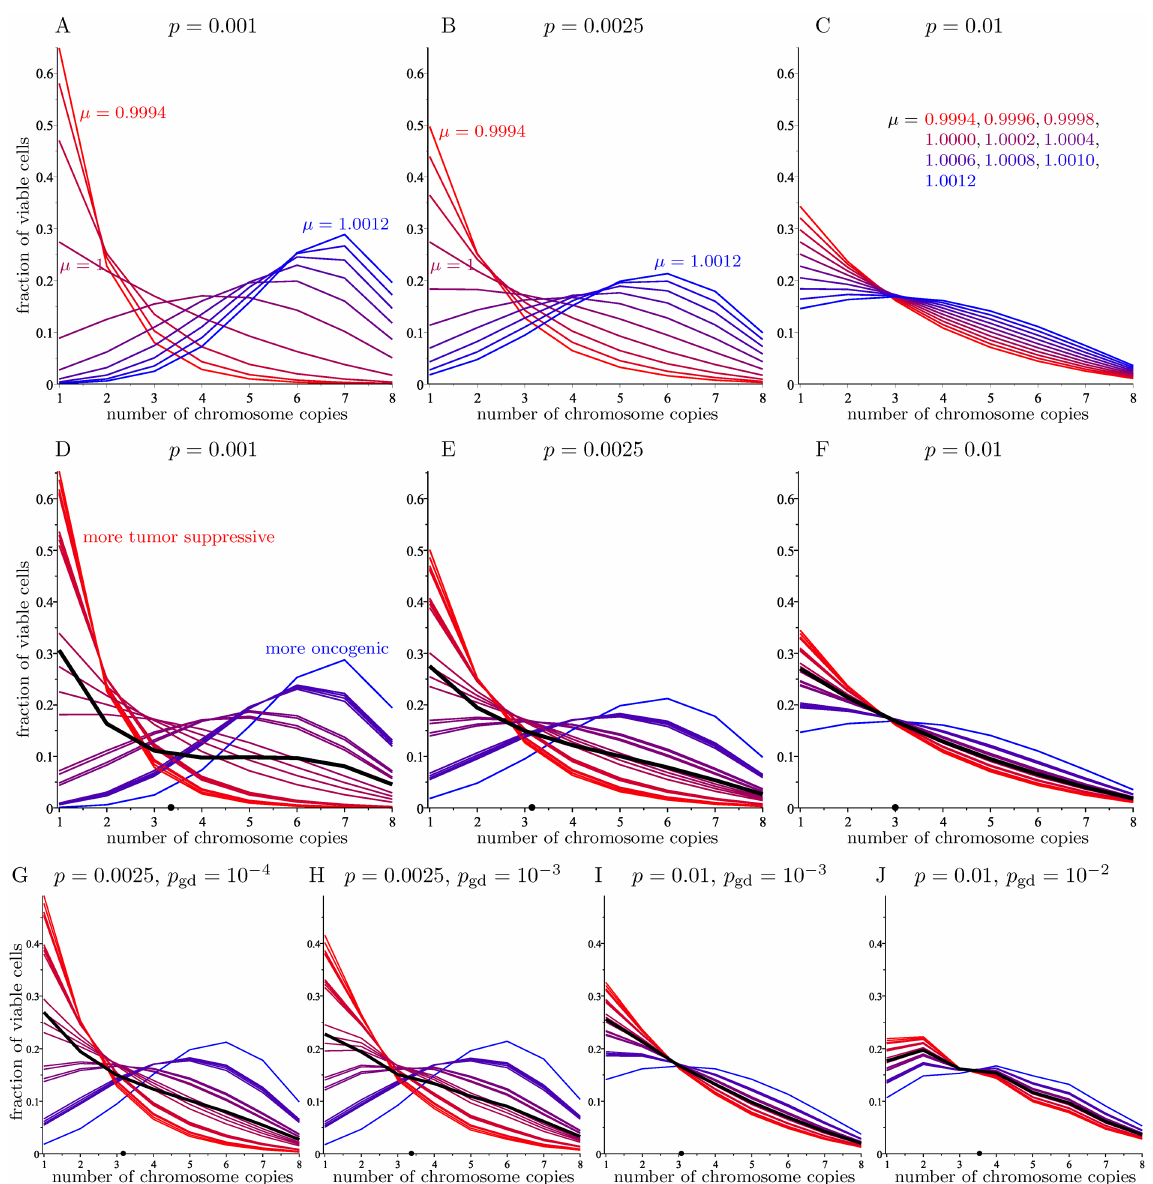
Fig 6. The limiting distribution on viable cells for the full model with N = 8. The horizontal axis indicates the number of copies of the chromosome, and the vertical axis measures the fraction of cells (among viable ones). A—C: Full model ( A ) for different values of p , and μ ranging in the interval [0.9994, 1.0012]. D—F: Full model ( A ) with the experimental values of μ corresponding to the 23 human chromosomes, for different values of p . The colors depict how oncogenic (blue) or tumor suppressive (red) each chromosome is. The average of the 23 limiting distributions is shown in black. The average number of chromosome copies in this average distribution is represented by a dot on the x -axis. G—J: Modified model with whole genome duplication for different values of p and p gd , together with the average of the 23 limiting distributions. The value p gd = 0 corresponds to the full model depicted in panels